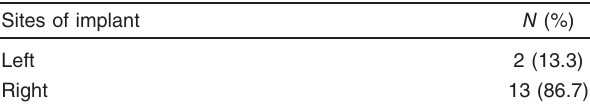
Table 2 Distribution of the studied cases according to site of implants ( n = 15) Sites of